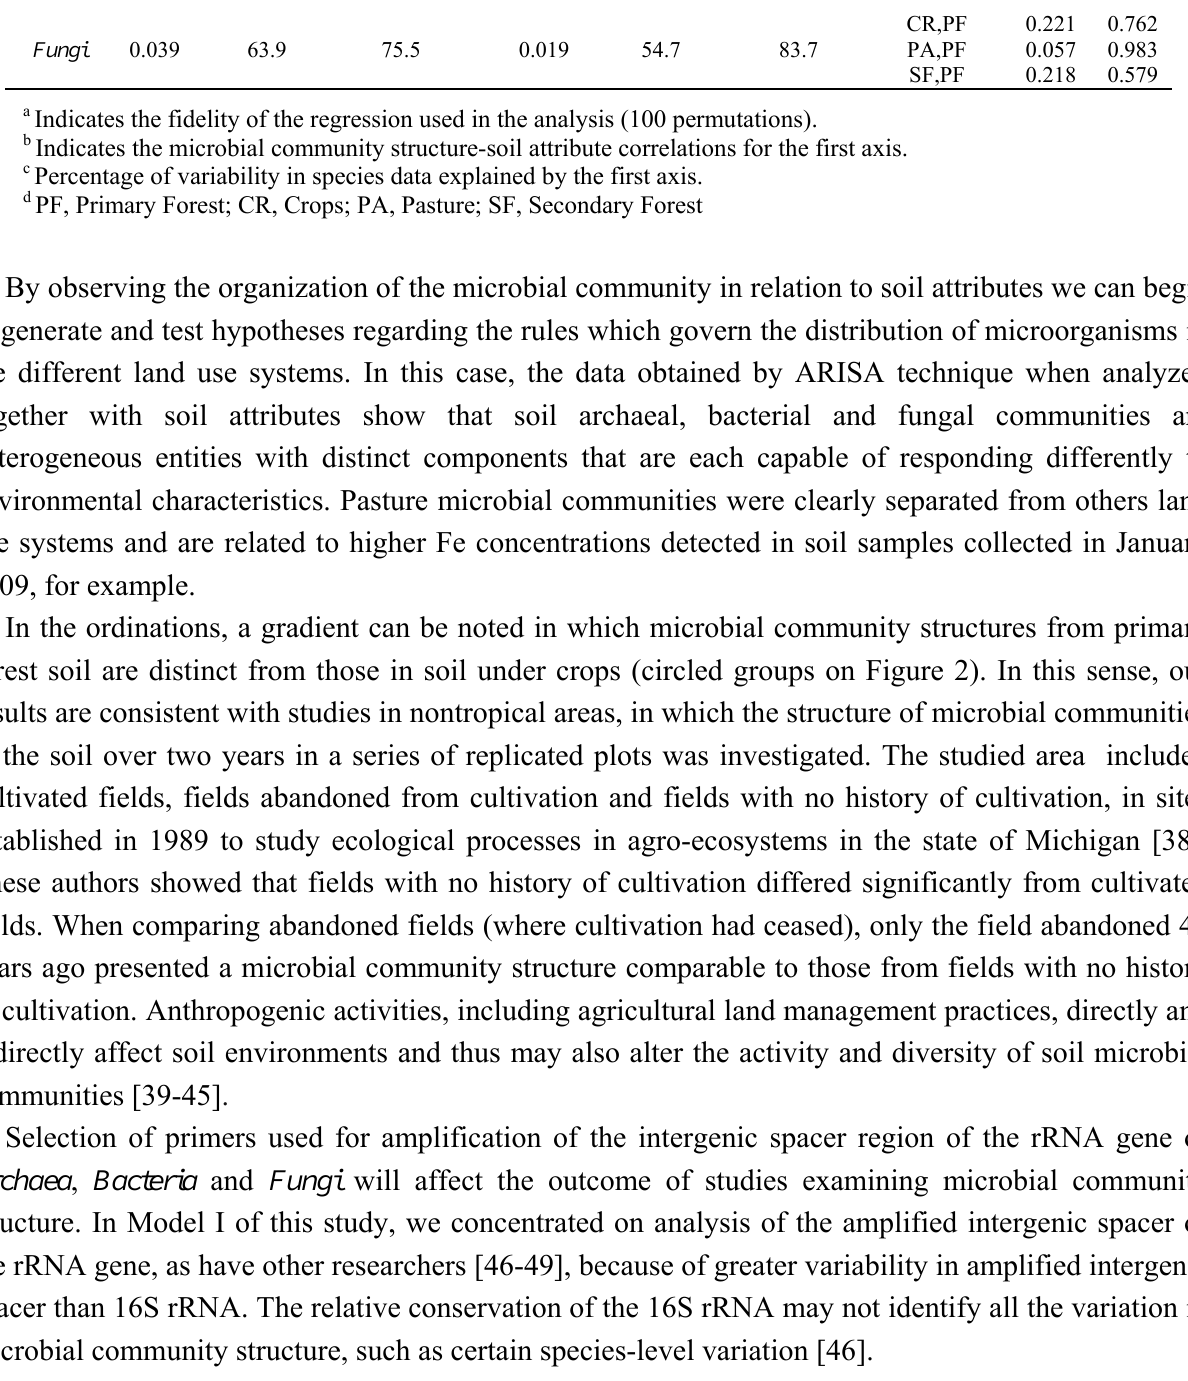
Table 2. Description of the non-metric multidimensional scaling (NMDS) and analysis of similarities (ANOSIM). NMDS Stress a Correlation b Variability c Stress a Correlation b Variability c Interactions d ANOSIM (%) (%) (%) (%) 2008 2009 2008 2009 CR,PF 0.275 0.881 Archaea 0.021 62.8 43.0 0.031 61.1 63.5 PA,PF 0.725 0.616 SF,PF 0.300 0.152 CR,PF 0.448 0.642 Bacteria 0.028 83.7 75.5 0.022 58.5 58.5 PA,PF 0.985 0.701 SF,PF 0.270 0.601 CR,PF 0.221 0.762 Fungi 0.039 63.9 75.5 0.019 54.7 83.7 PA,PF 0.057 0.983 SF,PF 0.218 0.579 a Indicates the fidelity of the regression used in the analysis (100 permutations). b Indicates the microbial community structure-soil attribute correlations for the first axis. c Percentage of variability in species data explained by the first axis.